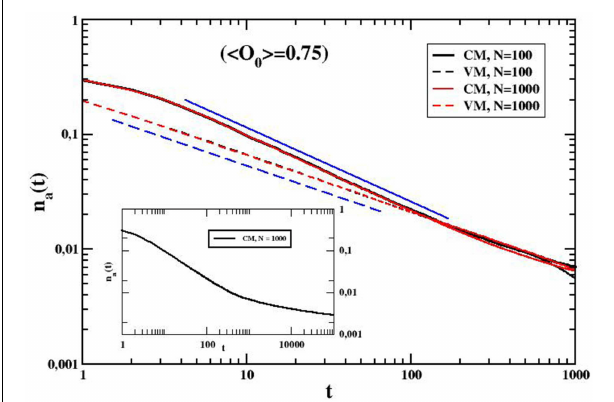
FIGURE 5 | Behavior over time of the (average) active bond density for the cognitive opinion model (CM) on a one-dimensional ring and initial average opinion h O 0 i = 0 . 75 . System size: N = 100 (full black line) and N = 1000 (full red line). Comparison with the voter model with the same parameters (dashed lines: black for N = 100 , red for N = 1000 ). The blue dashed line represents a power decay with exponent 1 / 2 , the blue straight one a power decay with exponent 2 / 3 . Inset: time behavior of the active bond density for CM with N = 100 up to t = 10 5 . Averages over 2000